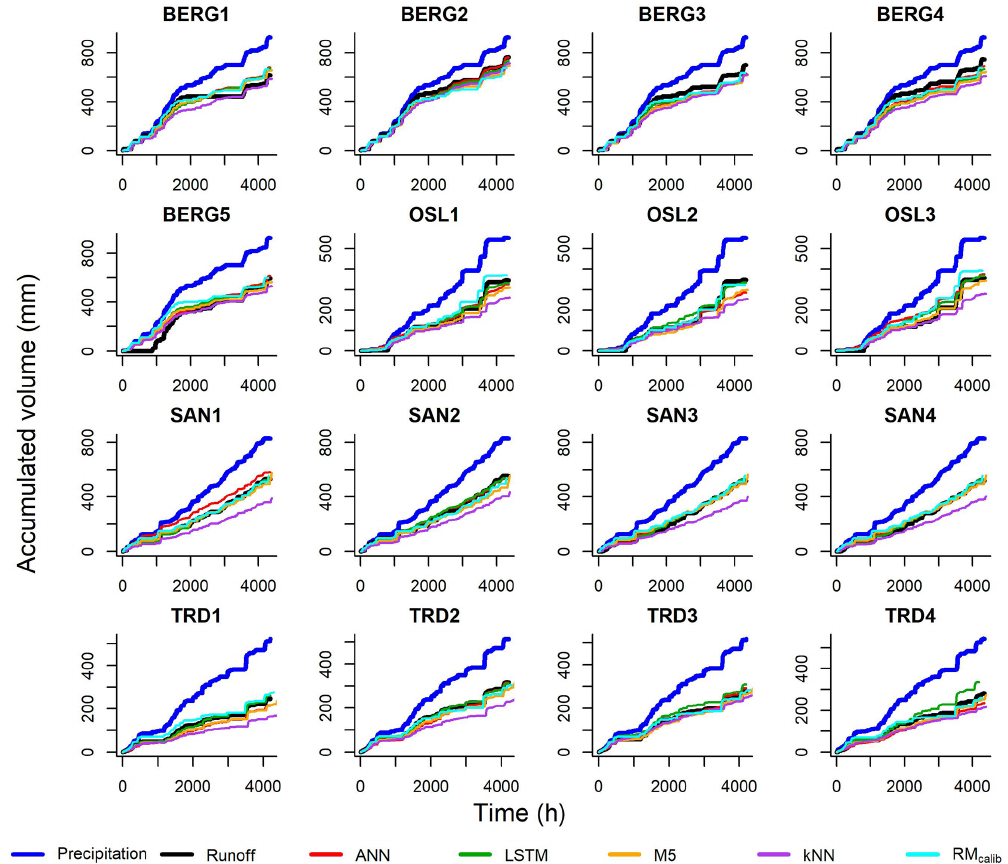
Figure 5. Cumulative precipitation, observed and simulated runoff of the green